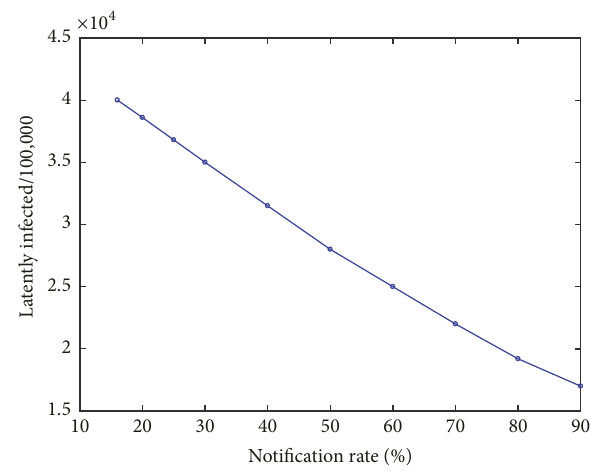
Figure 8: Hypothesis 3: latently infected population after 10 years of simulation of the model with different notification levels. Each point of the curve represents the corresponding population of the latently infected compartments, when the model is simulated with the corresponding notification rate on the